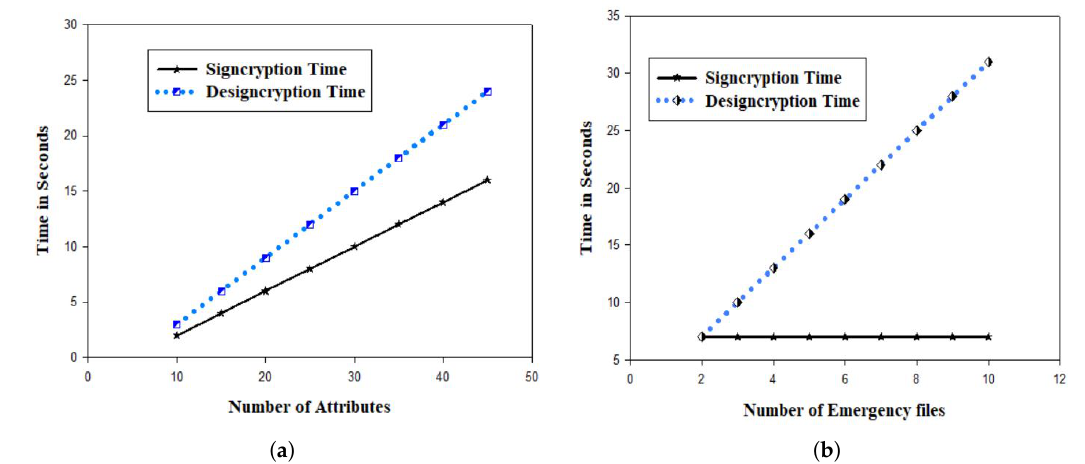
Figure 2. Signcryption/DesigncryptiontimeversusNumberofAttributes( a )andSigncryption/Designcryption time versus Number Emergency Files ( b ).